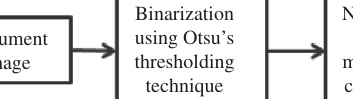
Figure 1: Block Diagram of the Present Word Searching Technique.